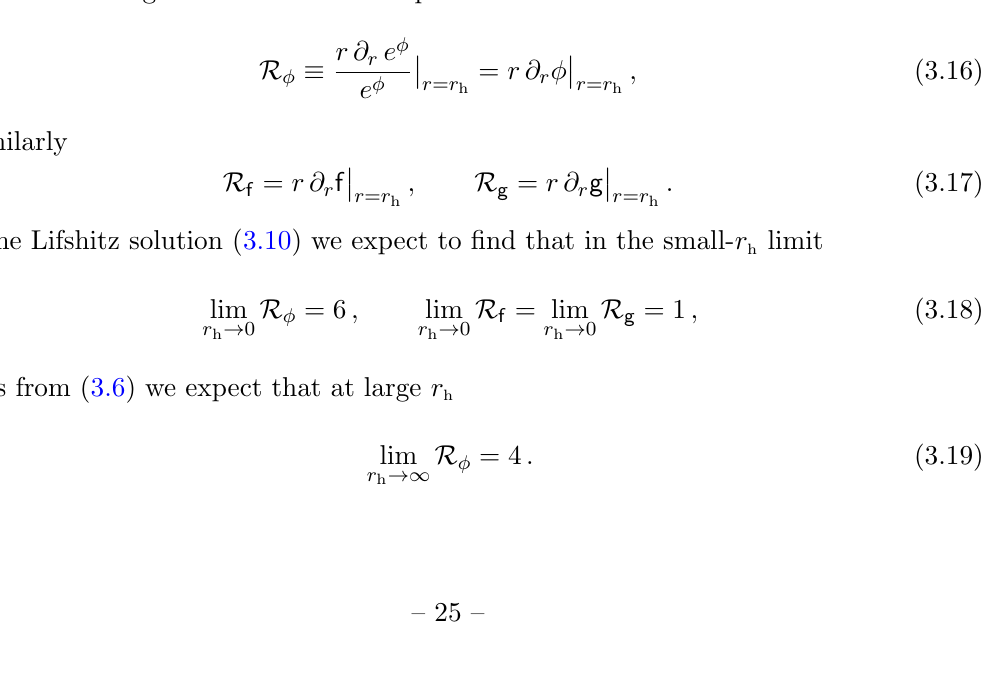
Figure 10. UV coe(cid:14)cients (cid:20) f and (cid:20) f